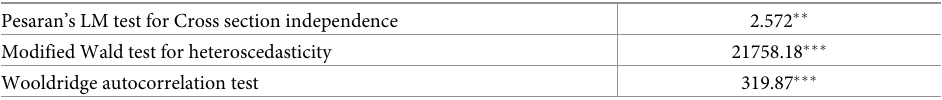
Note: This Table shows the cross section independence, heteroscedasticity, and autocorrelation test results. LM = Lagrange Multiplier.